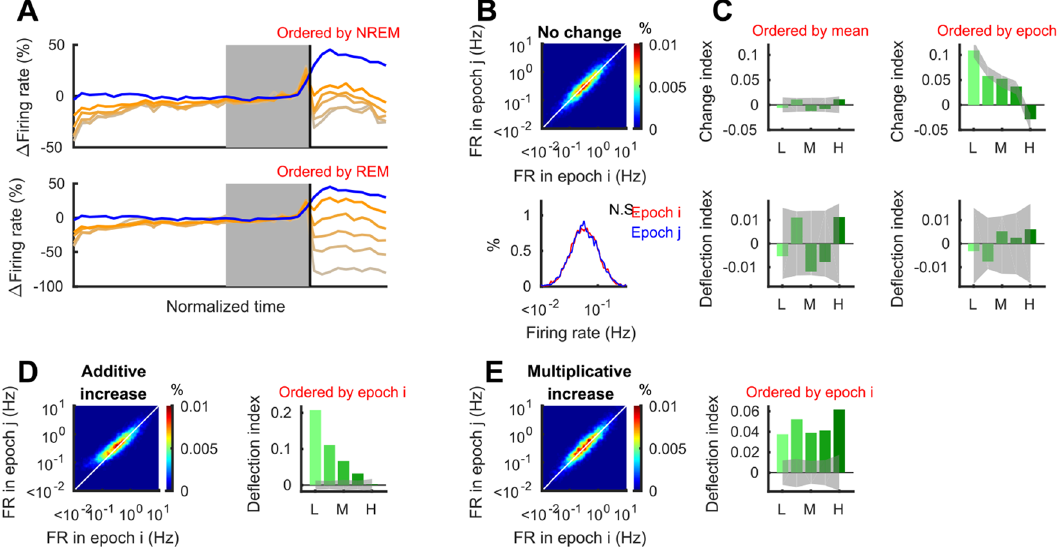
Figure 3. Deflection index can evaluate firing rate changes with correction for RTM. ( A ) Mean firing rates of hippocampal neurons in NREM-REM sequences as shown in Fig. 1B but different quintile separation (based on mean within NREM and REM for top and bottom, respectively). ( B ) Randomly generated firing rates with no change. ( C ) When cells are ordered based on the mean across combined states 1 and 2 (left column), there are no systematic difference on change index across quintiles. On the other hand, when cells are ordered based on state 1 alone (left column), systematic changes appear due to RTM. Deflection index ( DI ; for details see Material and Methods) can compensate for the effect of RTM (bottom panels). ( D , E ) In cases with non-zero changes in firing rate, DI is also significantly different from zero. Example of additive increase ( D ) and multiplicative increase ( E ). Gray bands indicate 95% confidence intervals obtained from shuffling (2000 times). Each example has 5000 cells whose firing rates are distributed